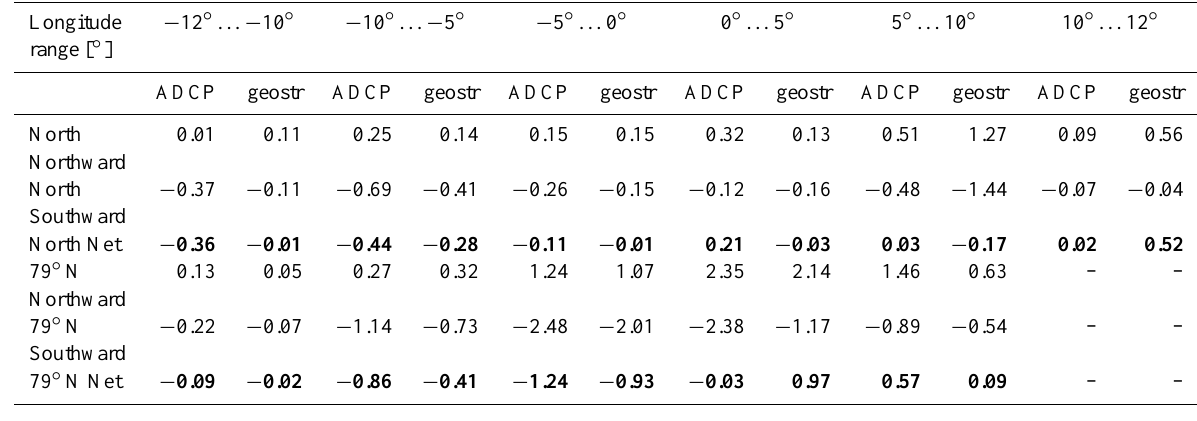
Table 3. 2004 volume transports of a surface layer at 35 to 425m depth divided to about 5 ◦ sections from ADCP velocities taken at every 0.25 ◦ and from geostrophy with constraints applied. Transports are positive northward and negative southward. Longitude